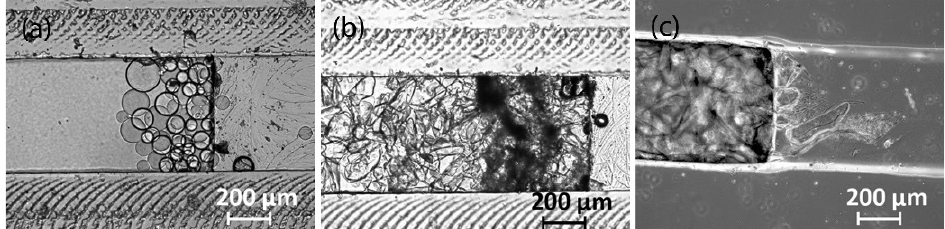
Figure 21. Microfluidic chip replica fabricated through milling on ABS. ( a ) Flat sieve retaining spherical particles. ( b ) Flat sieve retaining non-spherical particles. ( c ) Acetone polished flat sieve retaining non-spherical particles.